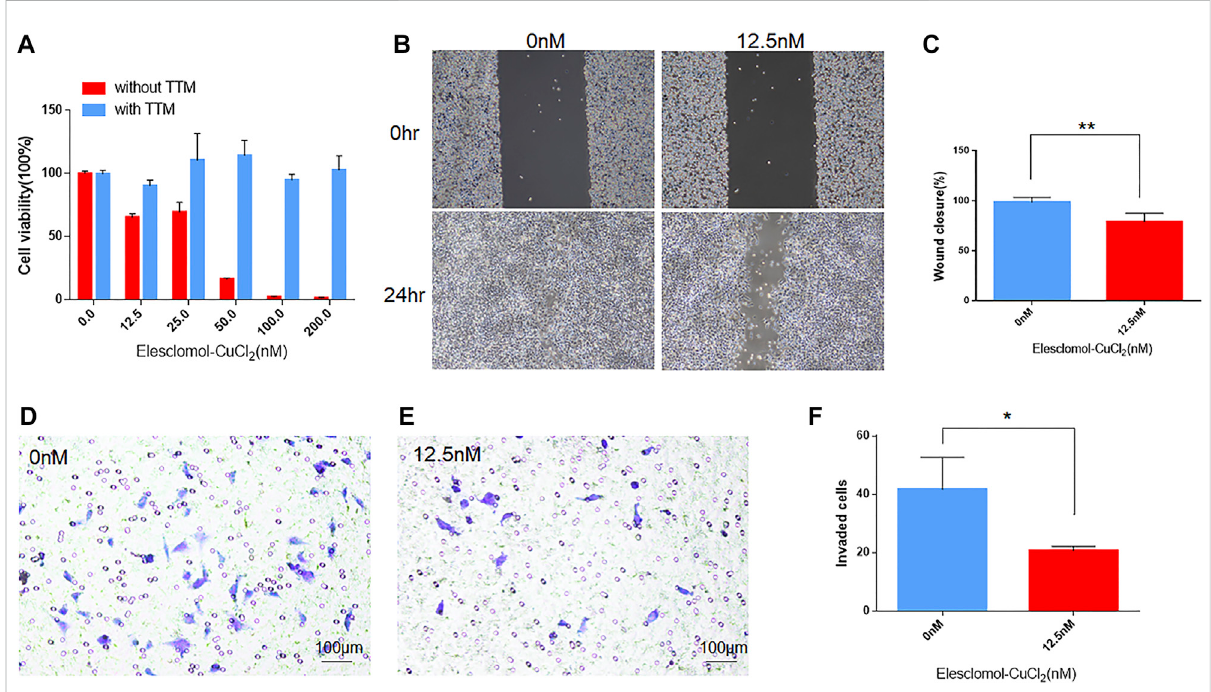
FIGURE 8 TheeffectofcuproptosisonUVMcells. (A) Incellviabilityassay,bluebarsindicatecellstreatedwithcuproptosisinhibitorTTM,redbarsindicate cells treated withoutTTM. With the subsequent increasing concentration of cuproptosisinducer elesclomol-CuCl 2 (elesclomol mixed with CuCl 2 at 1:1 ratio), cell viability decreased. (B) In migration assay, the left panels showed the wound width of M619 cells without elesclomol-CuCl 2 at 0 and 24 h, the right panels showed the wound width of M619 cells with 12.5 nm elesclomol-CuCl 2 at 0 h and 24 h. (C) Wound closure rate is compared between cells with 0 and 12.5 nm elesclomol-CuCl 2 at 24 h. (D) In transwell invasion assay, representative images of the penetrated M619 cells treated with 0 nm elesclomol-CuCl 2 . (E) Representative images of the penetrated M619 cells treated with 12.5 nm elesclomol-CuCl 2 . (F) Comparison of the invaded cells treated with 0 and 12.5 nm elesclomol-CuCl 2 .** p value < 0.01; * p value <